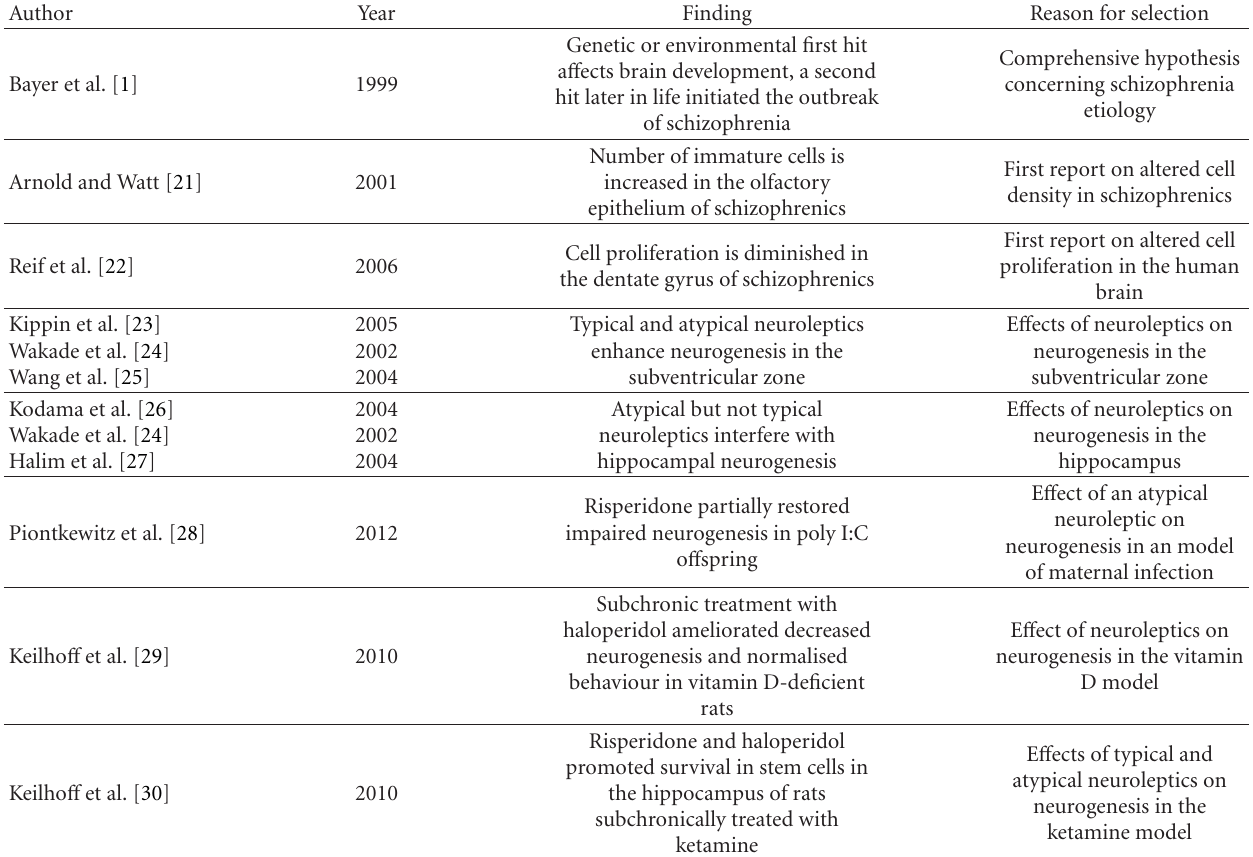
Table 1: Critical selection of most relevant papers published in the last 13 years.